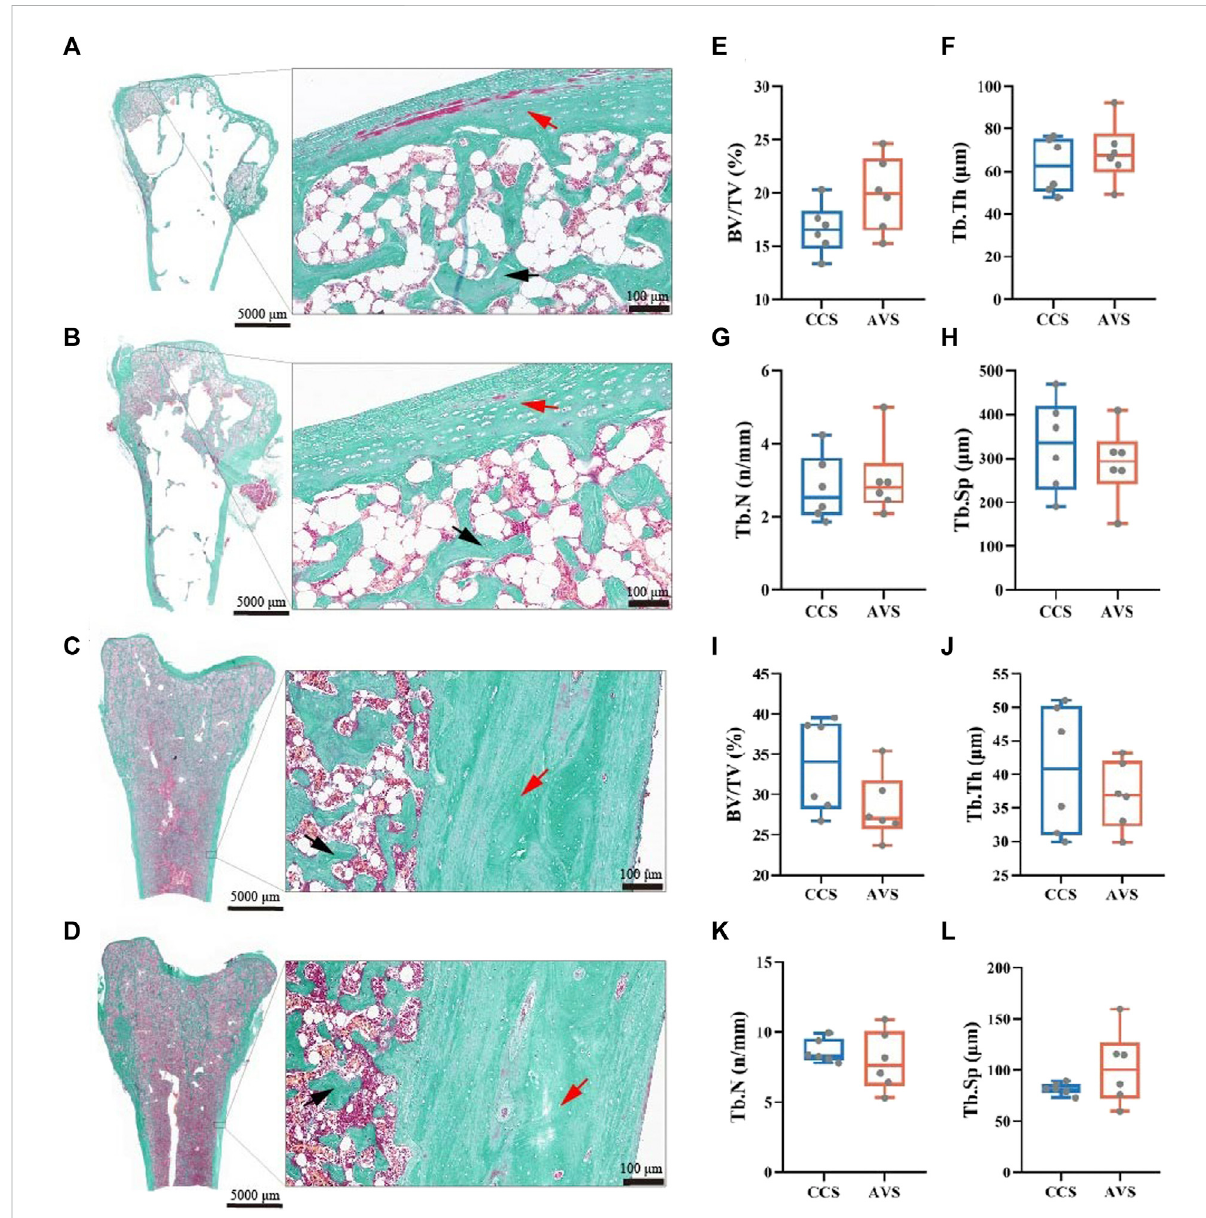
FIGURE 4 Effect of rearing systems on bone histomorphometry ofaged laying hens (95 weeksof age) [humerus, (A,B,E – H) ; femur, (C,D,I-L) ]. Humeriand femurs were sectioned and stained with Goldner ’ s trichrome [ (A,C) , the CCS group; (B,D) , the AVS group; red arrow, cortical bone; black arrow, trabecular bone]. (E,I) Trabecular bone volume/tissue volume (BV/TV), (F,J) Trabecular thickness (Tb.Th), (G,K) Trabecular number (Tb.N), (H,L) Trabecular separation (Tb.Sp). BV/TV, Tb.Th, Tb.N and Tb.Sp were counted under blinded analysis (n = 6). CCS, conventional caging system; AVS, aviary